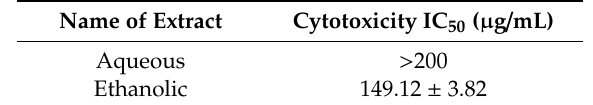
Data are presented as mean ± SD values of five replicate determinations.